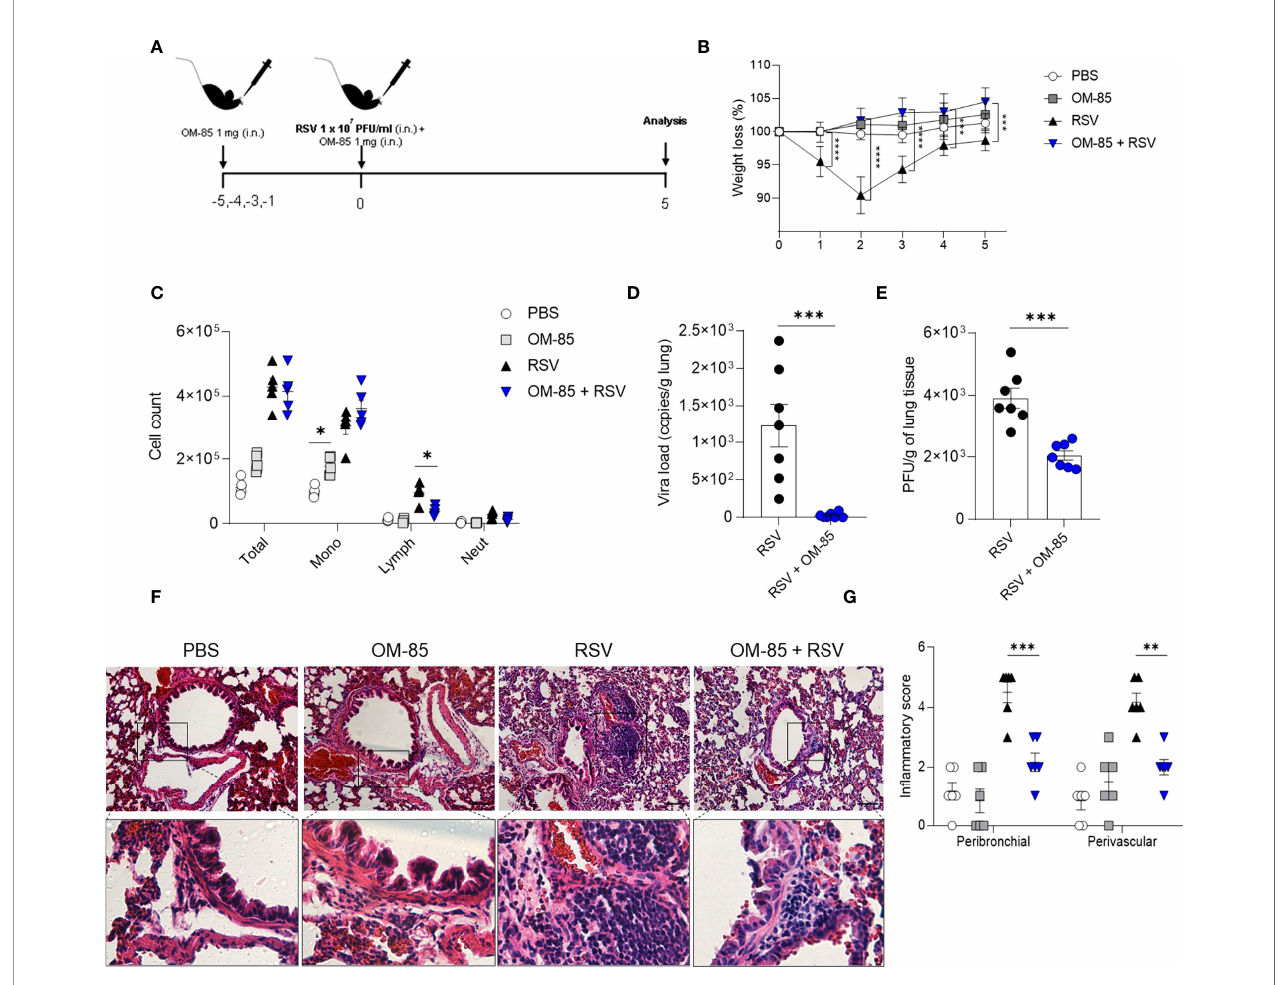
FIGURE 4 | OM – 85 pretreatment starting 5 days prior to infection robustly confers protection and viral clearance during RSV – induced disease. Mice were treated intranasally with OM – 85 (1mg) 5 days prior to RSV infection (four OM – 85 delivery). Afterwards, mice were infected with RSV (1x10 7 PFU/ml) and received another OM – 85 boost 6h later. (A) Experimental design. (B) Percentage of weight loss relative to day 0 (right before infection). (C) Total cell number and differential cell counts in BAL. (D) RSV viral load detected in lung tissue by real – time PCR (viral copies/g of lung tissue). (E) Viral titer in the lung (PFUs/g lung tissue). (F, G) Representative images of lung tissue section stained with H&E and its respective in fl ammation scores. Scale bars=200 m m. Data from 3 independent experiments (n = 8 per group). All data are expressed as mean±SEM. Multiple groups were compared using Kruskal – Wallis, except in (D, E) in which the comparison between groups was made using Mann